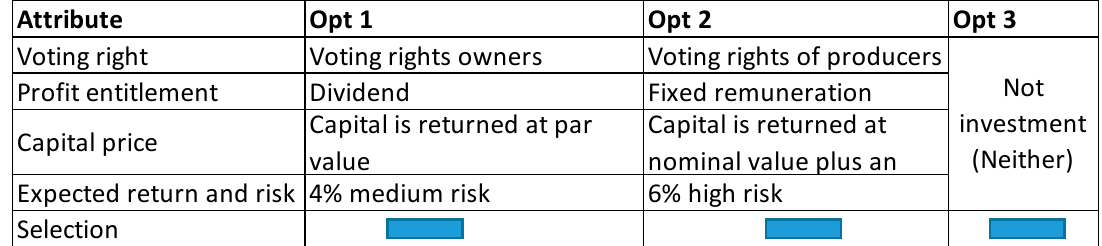
Figure 1. Example Choice Set.